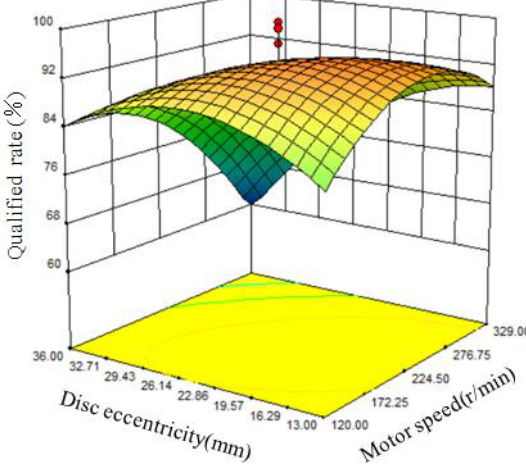
Figure 14. Interaction between motor speed and disc eccentricity.